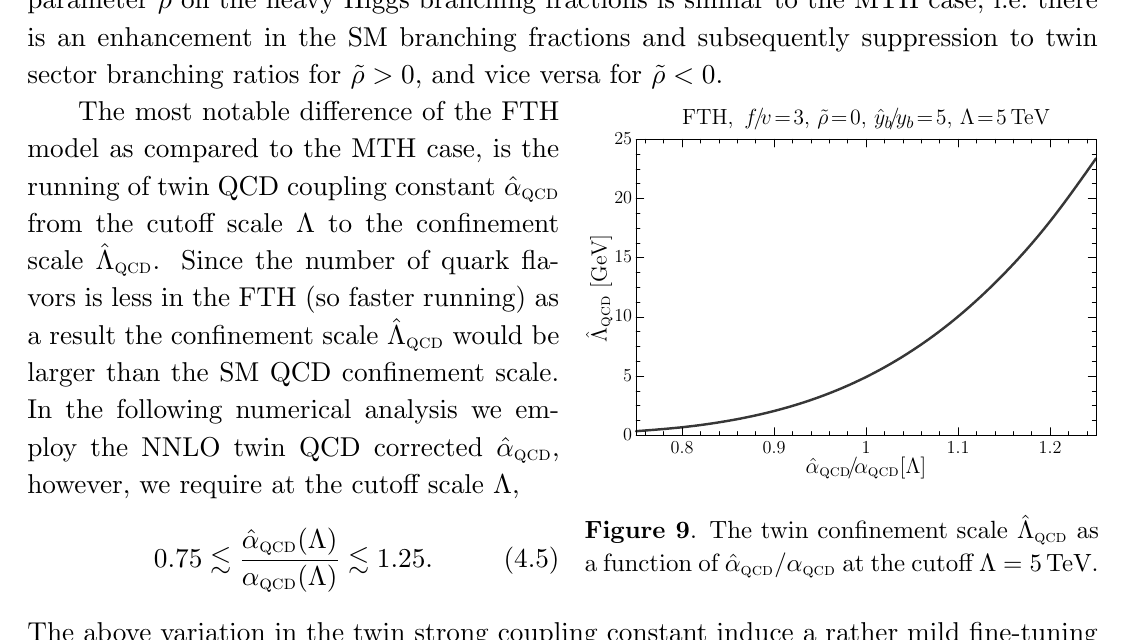
; m ^0 ) = (15 ; 50) GeV and + b